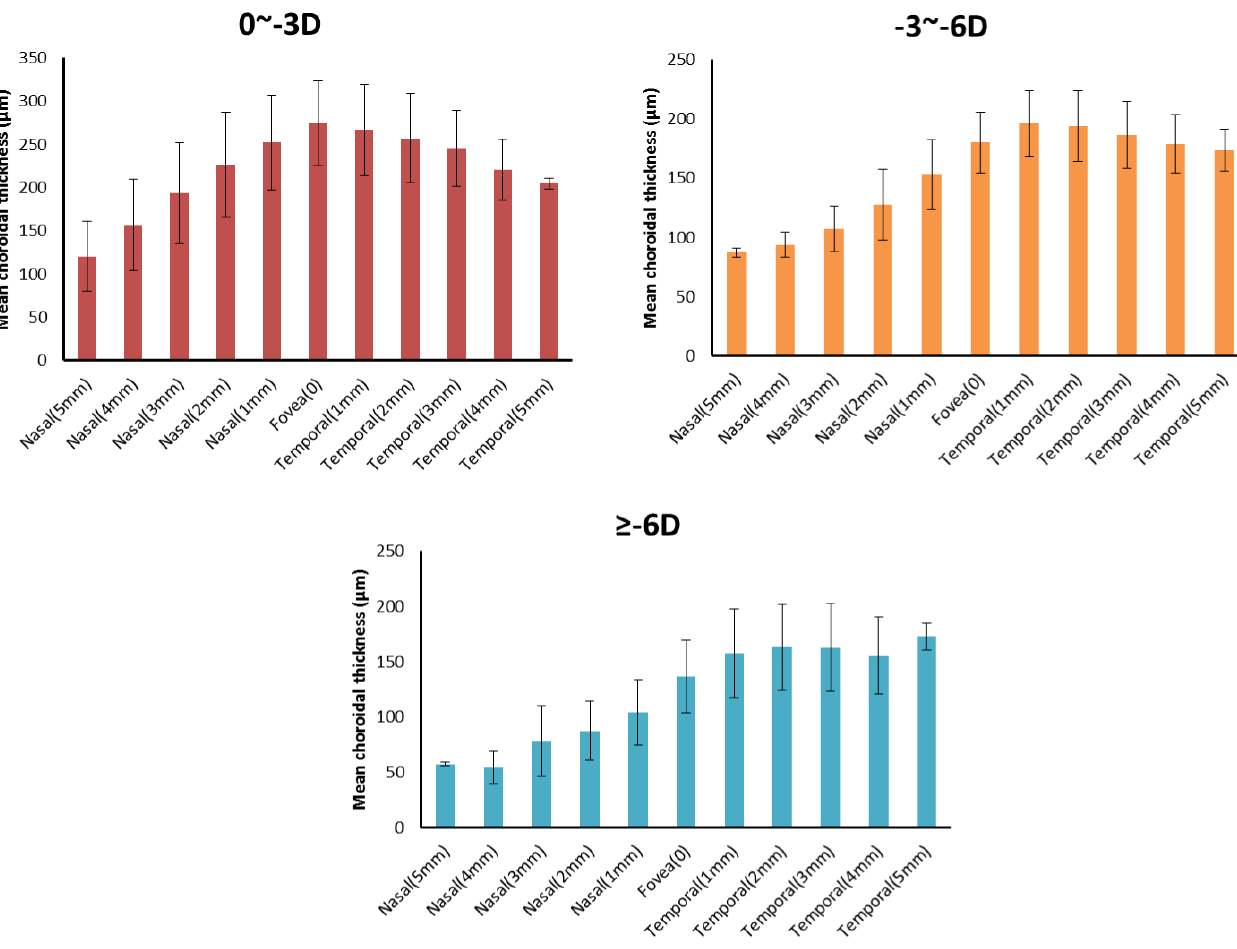
Fig. 5. The CT distributions from nasal to fovea to temporal with an interval of 1 mm of low, moderate, and high